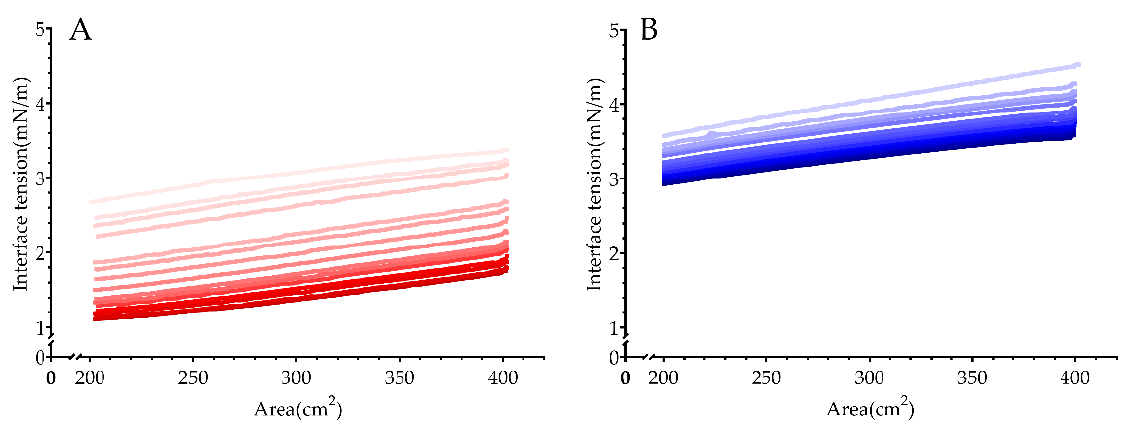
Figure 2. Interfacial tension-area ( π -A) isotherm of surfactants at oil-water interface. ( A ) polyglycerol-2 dioleate; ( B ) PGPR (color from light to deep for 1–15 times compression).